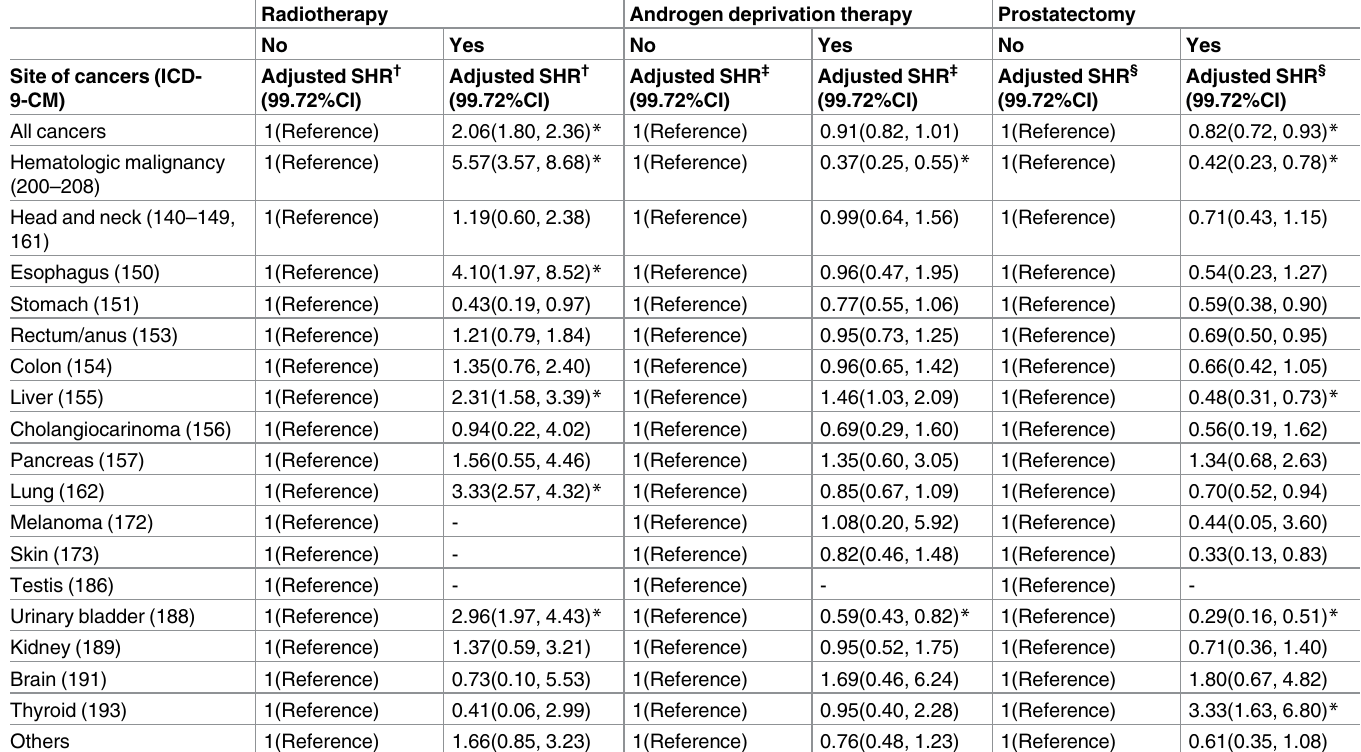
Table 4. Comparison of subhazard ratios of types of second primary malignancies according to treatment status among patients with prostate cancer. Radiotherapy Androgen deprivation therapy